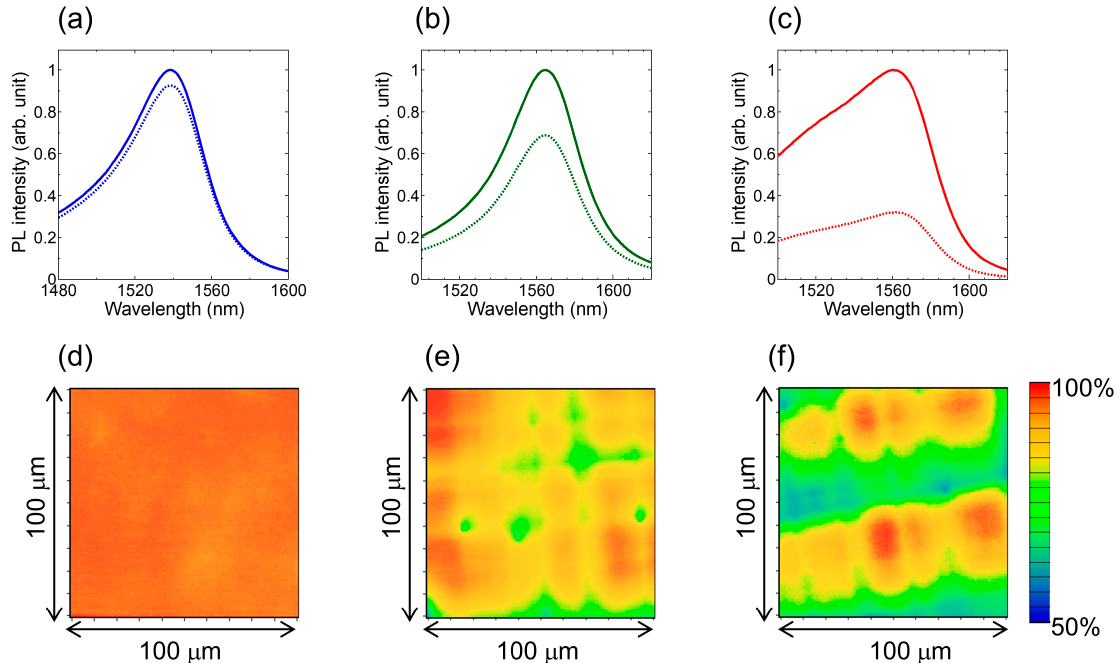
Figure 4. ( a – c ) PL spectra for MQW ‐ DHs with different total thicknesses on SiO 2 /Si substrates before (solid lines) and after (dashed lines) annealing; ( d – f ) PL ‐ intensity map measured with PL microscope after annealing.